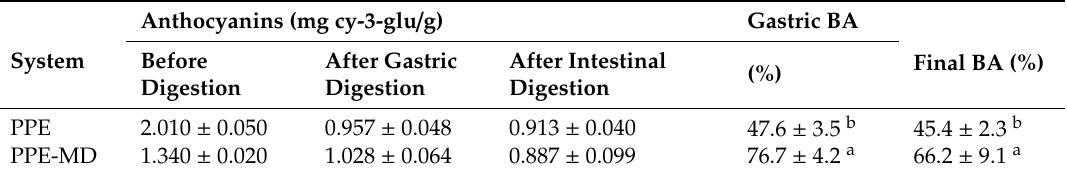
Final BA (%)Before (%)